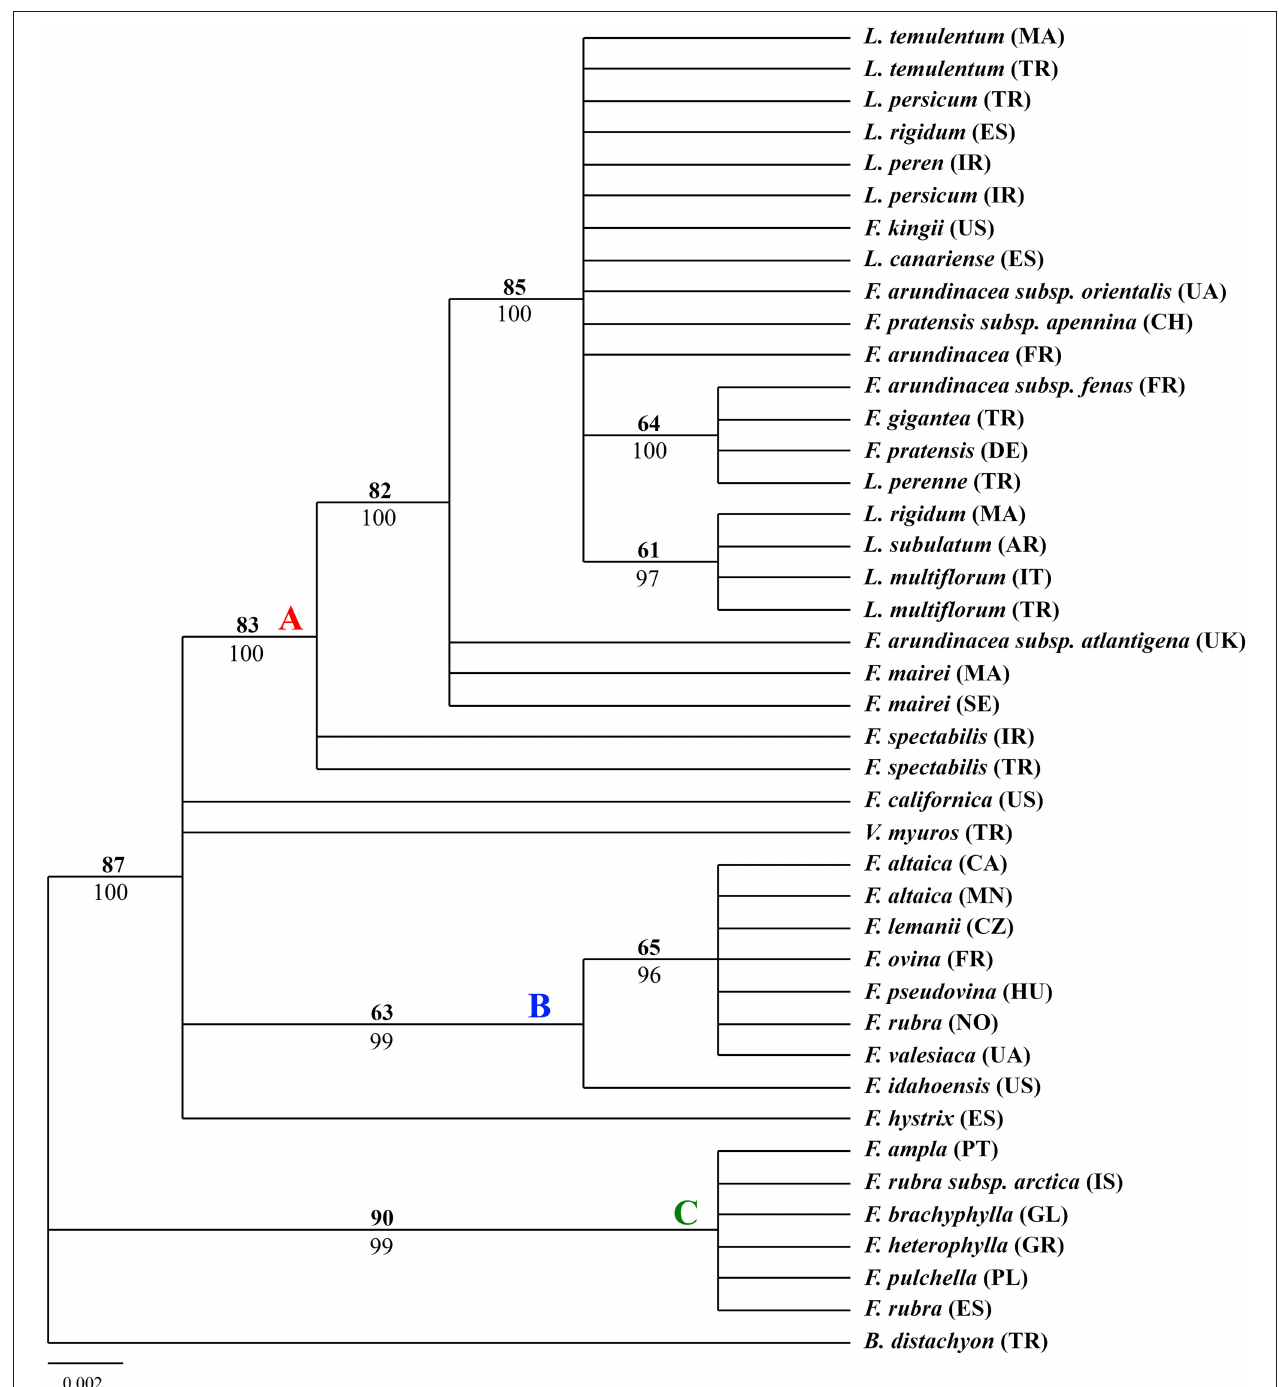
FIGURE 2 | Fifty-percent majority-rule BI tree inferred from the chloroplast gene rbc L sequences of Festuca / Lolium examplers. The number above and below the braches indicate boot strap values ≥ 50% and Bayesian posterior probability values ≥ 90%.